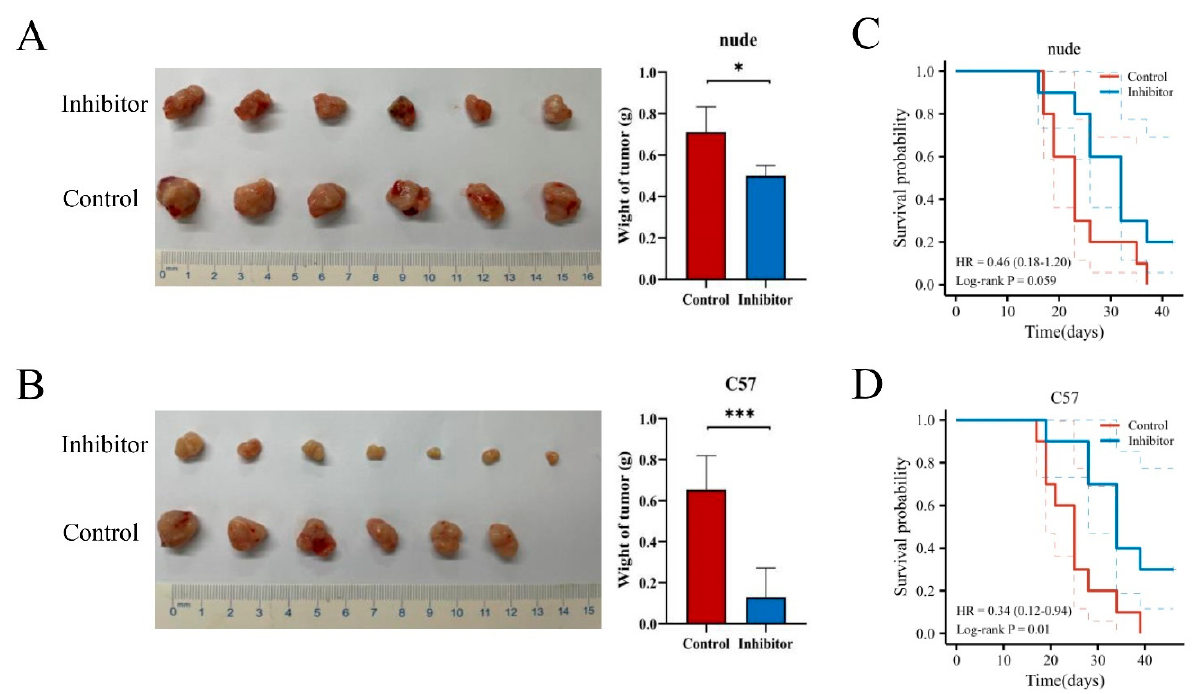
Figure 7. In vivo experiments. The visual maps of tumors, average tumor and tumor weight of the ( A ) immunodeficient nude mice (n = 6 per group) and ( B ) immunocompetent C57BL/6 mice (n = 7 per group). The growth curve of the ( C ) immunodeficient nude mice (n = 10 per group) and ( D ) immunocompetent C57BL/6 mice (n = 10 per group). * p < 0.05 and *** p < 0.001.